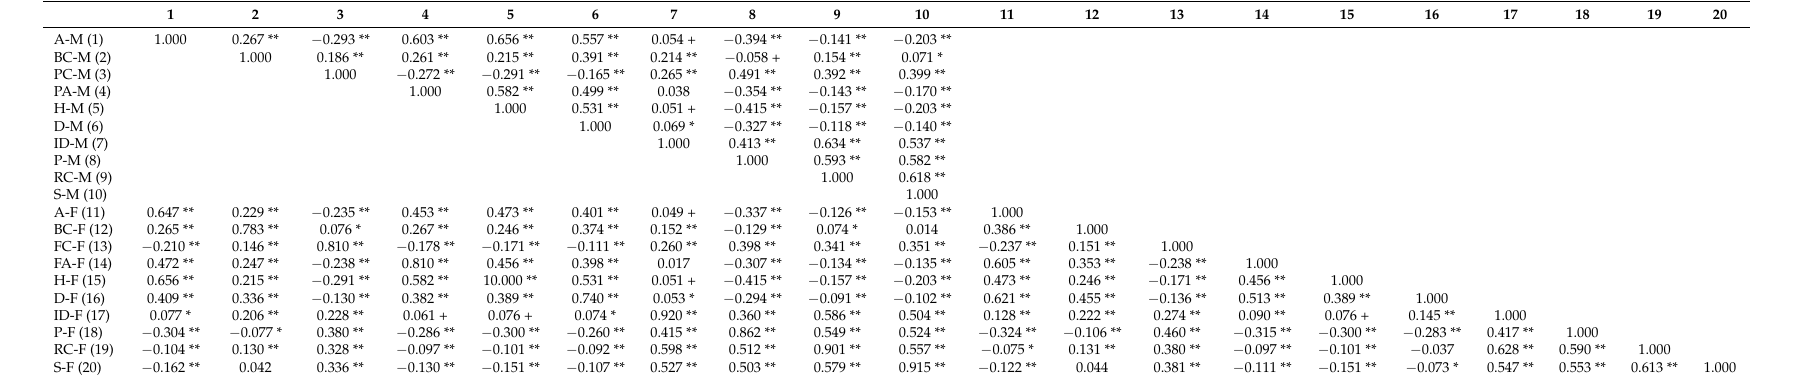
Table 1. Spearman’s correlation between parenting practices